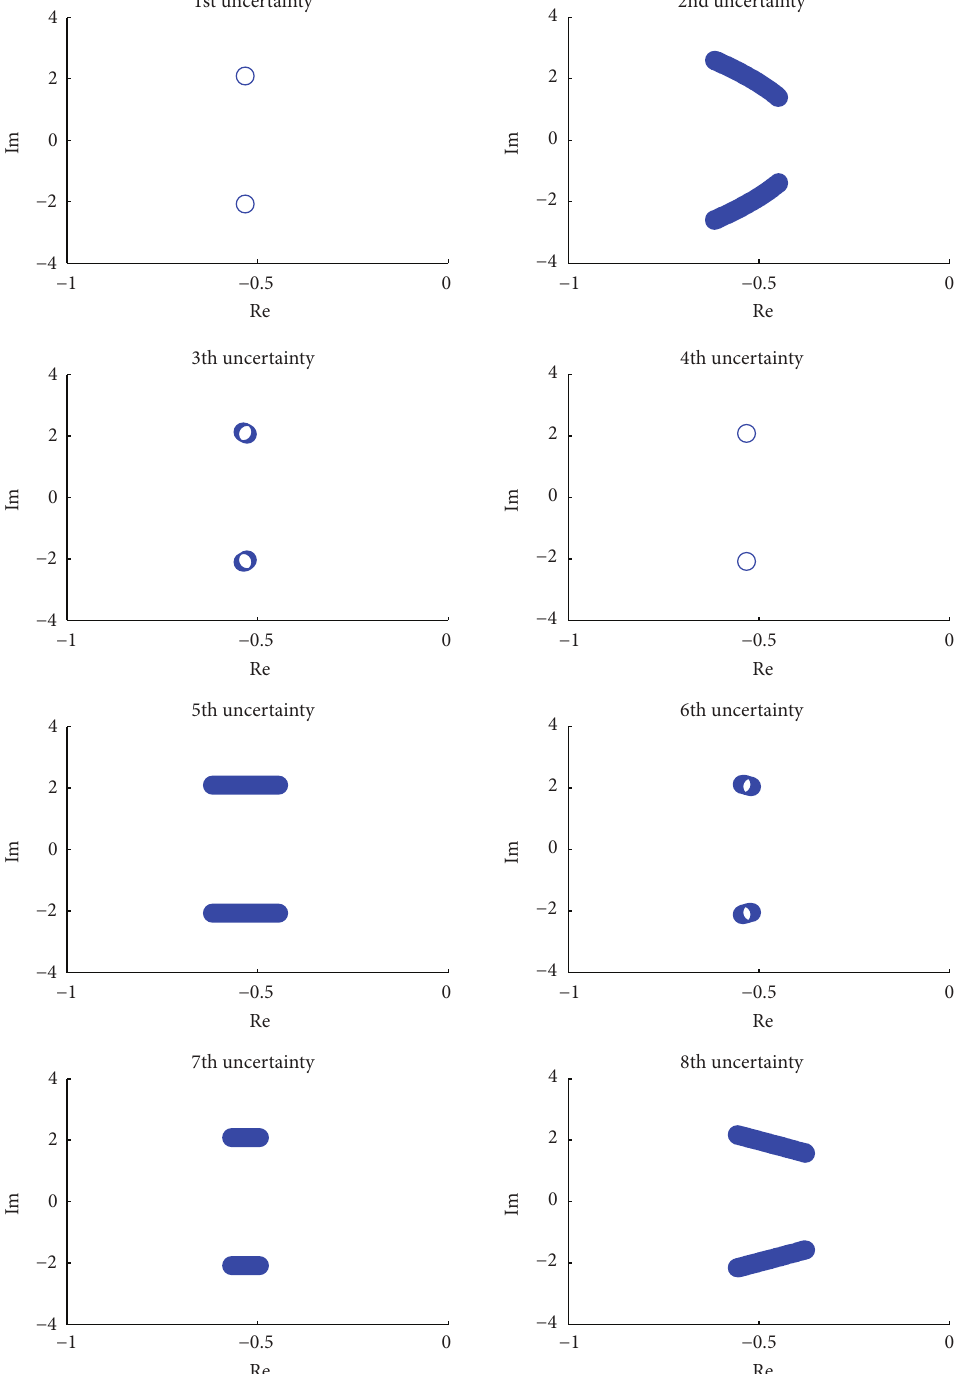
Figure 6: Dominant poles distributions for systems with one